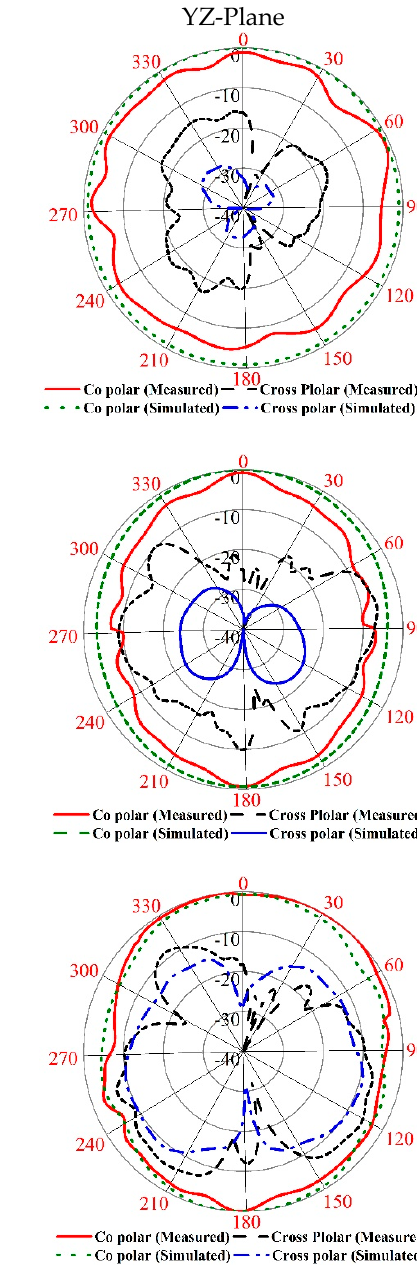
Figure 10. The 2D measured radiation pattern at ( a ) 3.25, ( b ) 6.5, and ( c ) 9.5 GHz.